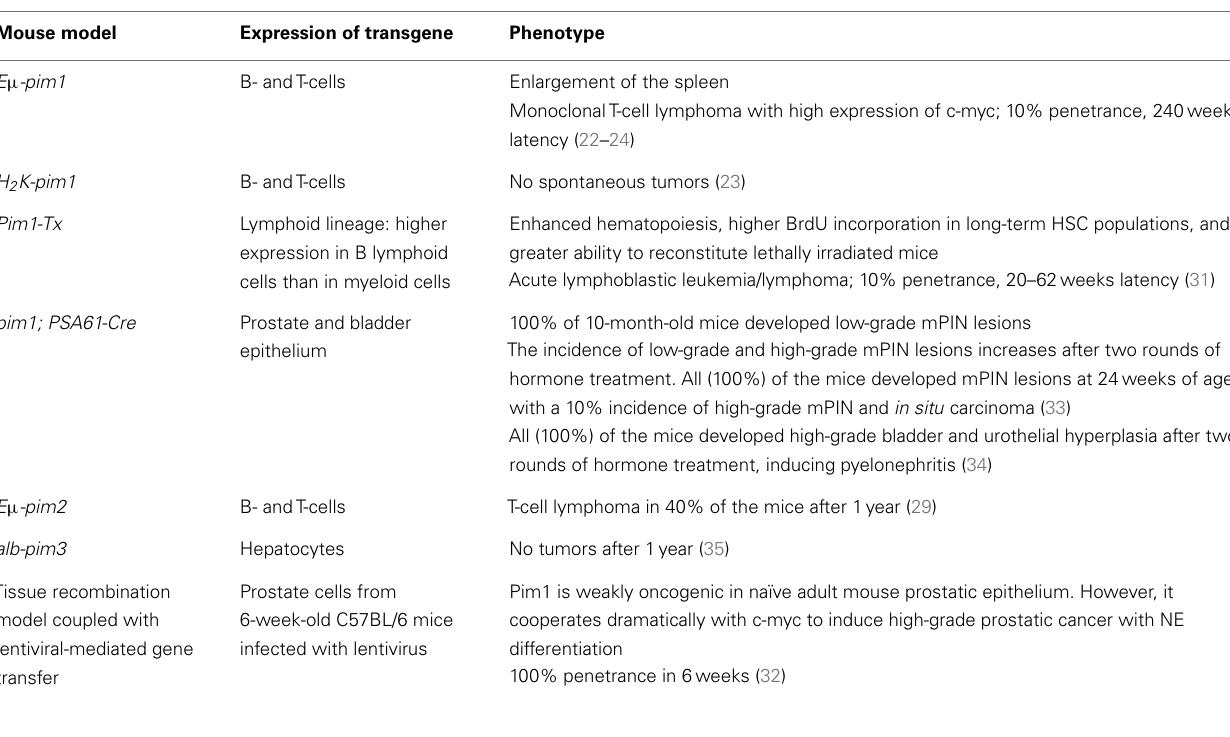
Table 2 | Mouse models overexpressing Pim proteins